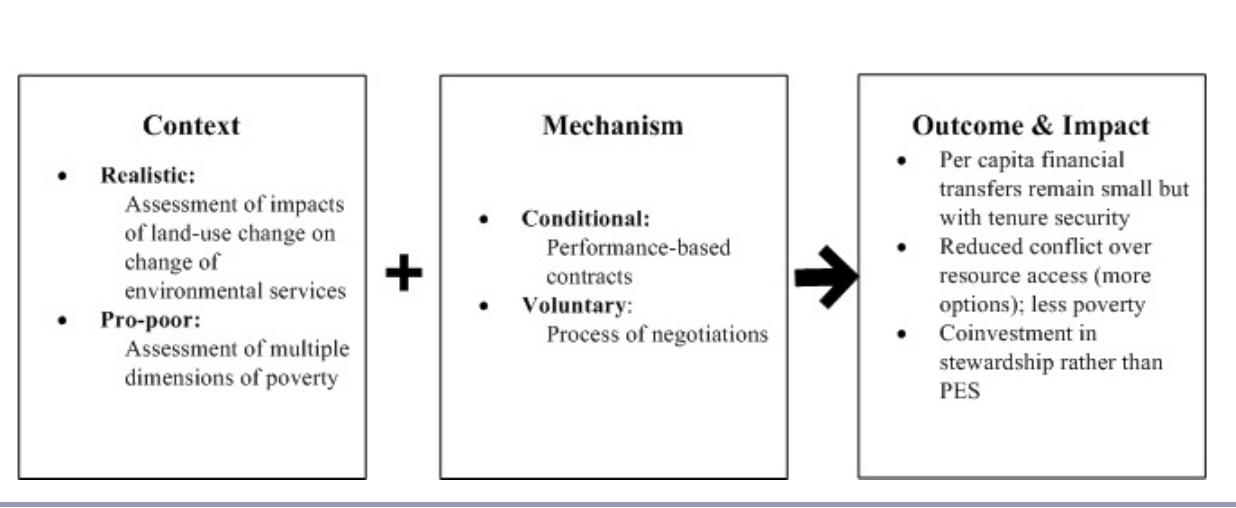
Fig. 2. Conceptual framework for establishing a pro-poor rewards scheme for agro-biodiversity